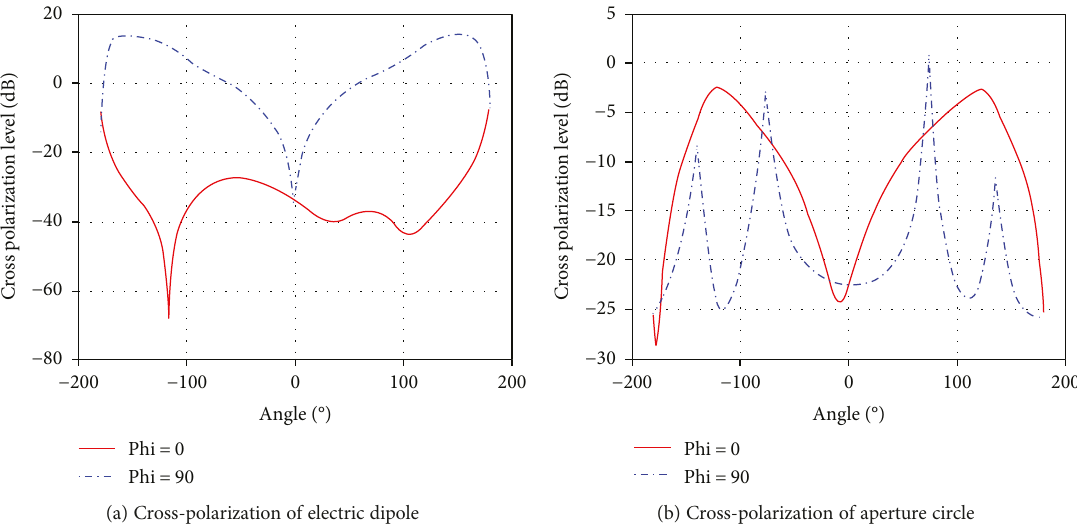
Figure 7: Cross-polarization simulation results of dual polarization antenna.